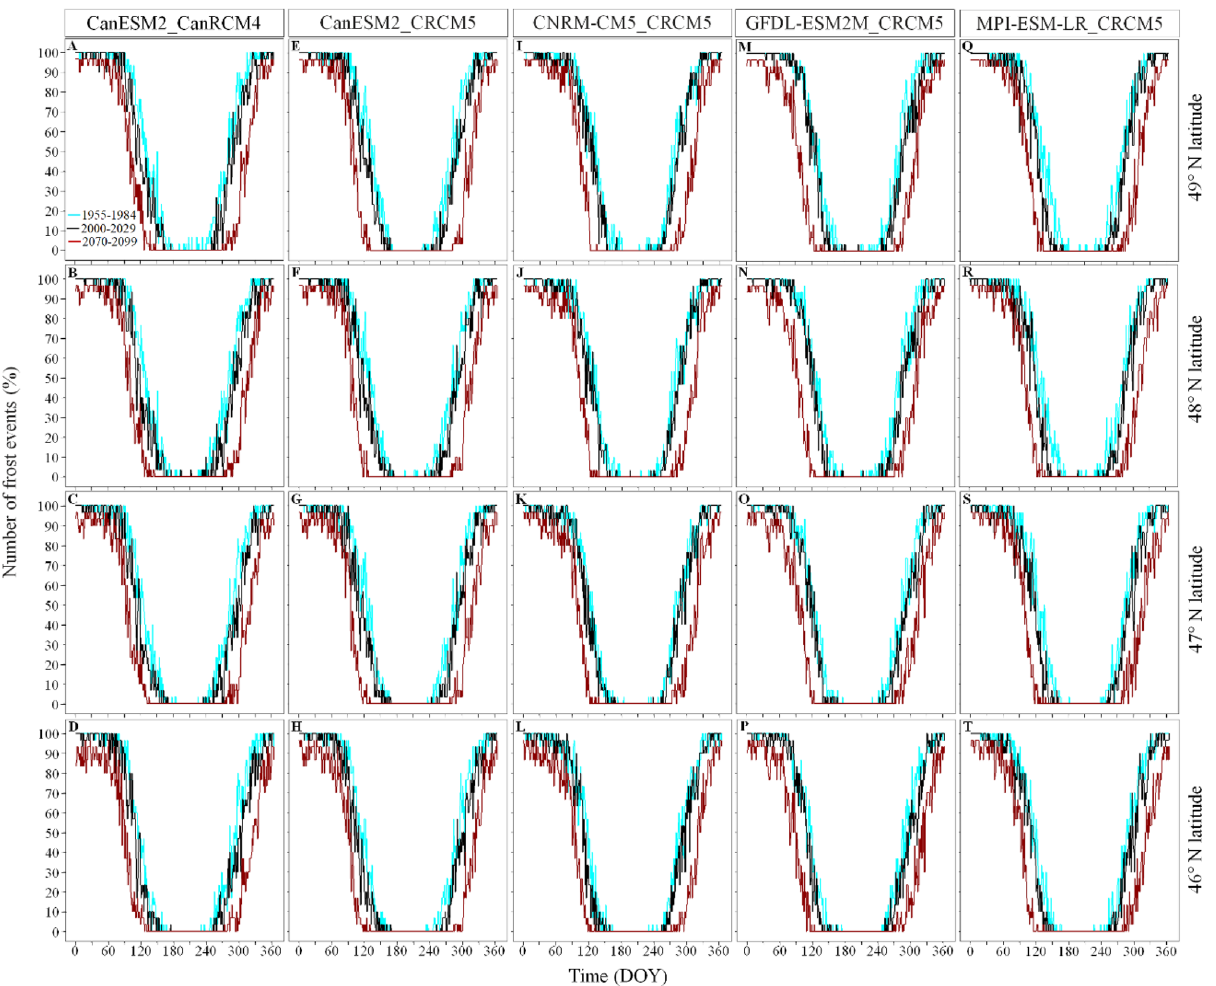
Figure 3. Percentage of frost events for each day of the year over three specific periods (1955–1985, 2000–2030, 2070–2099) along the latitudinal gradient per climate model used in the multi-climate model ensemble. The columns show the results of each climate model and the rows identify specific latitudes along the latitudinal gradient (46.09, − 77.28; 47.05, − 77.59; 48.17, − 77.50; 49.03, − 77.17). We used the ggplot2 library developed by Wickham 27 to produce the